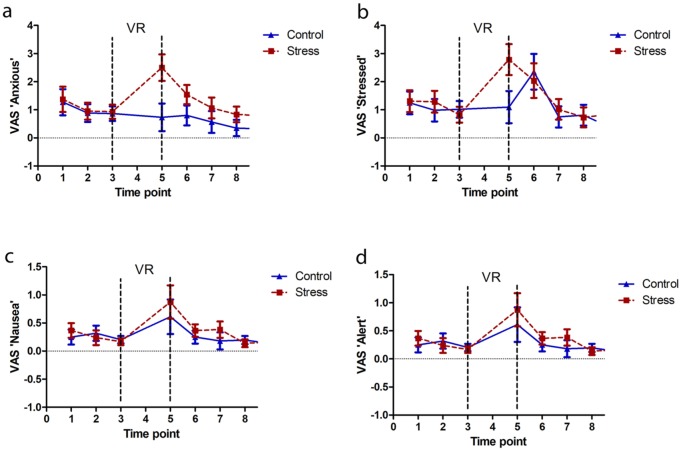
Variation in psychological indices across the experimental time course.
Changes in VAS ratings of (a) ‘Anxious’, (b) ‘Stressed’, (c) ‘Nausea’
and (d) ‘Alert’ over the course of the experiment in those randomised to
the control (blue triangles and solid lines) and stress (red squares and
dashed lines) elevator. Note that VAS ratings were not taken at T4 as
participants were in the VR. Vertical dashed lines indicate the period
that participants were immersed in the VR environment (i.e. from just
after time point 3 to just before time point 5).